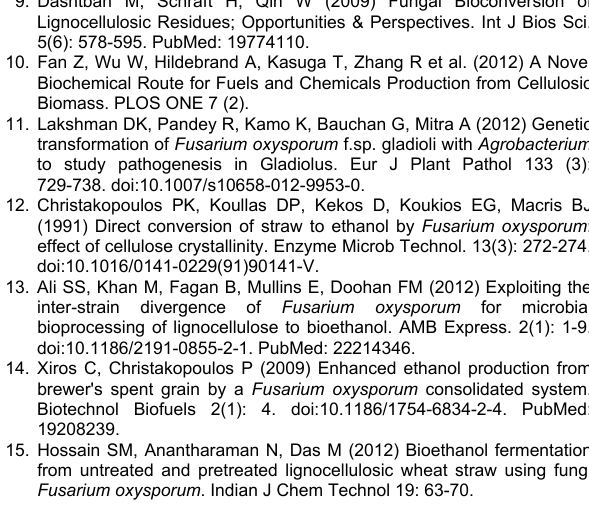
Figure S8. In silico analysis of identified coding sequence obtained via genome walking in Tr. 259. Sequence analysis of cloned PCR product obtained via genome walking within Fusarium oxysporum strain 11C transformant Tr. 259. Walking was from the right border (RB) of the transformation vector pSK1019 using the APA TM Gold Genome Walking Kit (Bio S&T, Canada), a universal kit primer (UAP-2) (red) and the gene- specific (GSP) primer (blue) (3’-5’) ( A ). Identified coding sequence was analysed against the F. f.sp. lycospersici (strain 4287) genome (FCGD; (http:// www.broadinstitute.org/annotation/genome/fusarium_group)) using Blastn ( B ) and Blastx ( C ).